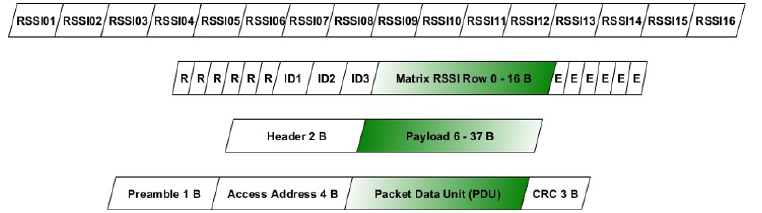
Figure 11. The structure of the communication package for transporting measurement data and calculating the RSSI